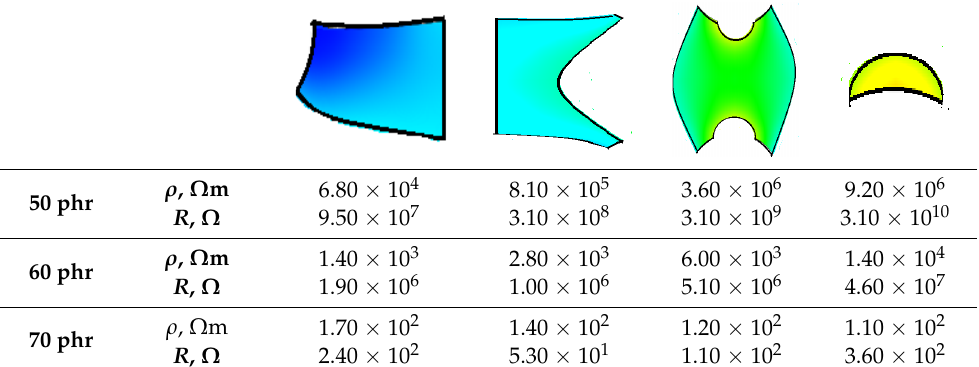
Figure 11. The resistivity of reference samples containing 50 phr CB, 60 phr CB and 70 phr CB vs. the sample’s strain and corresponding DIC domain’s color. Table 2. The calculated resistivity and resistance of separate domains (samples type b).